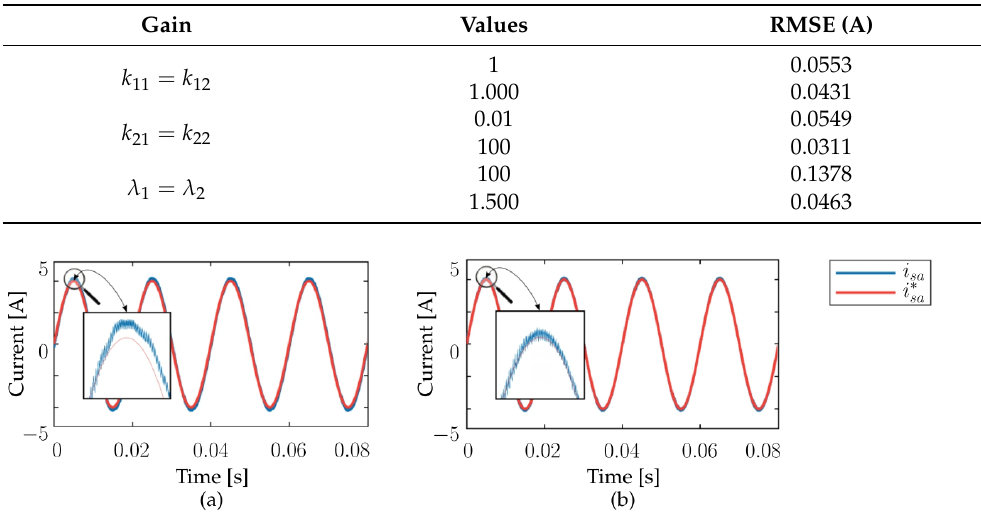
Figure 6. Gain adjustment results. ( a ) Λ = 0.0001. ( b ) Λ = 2000.